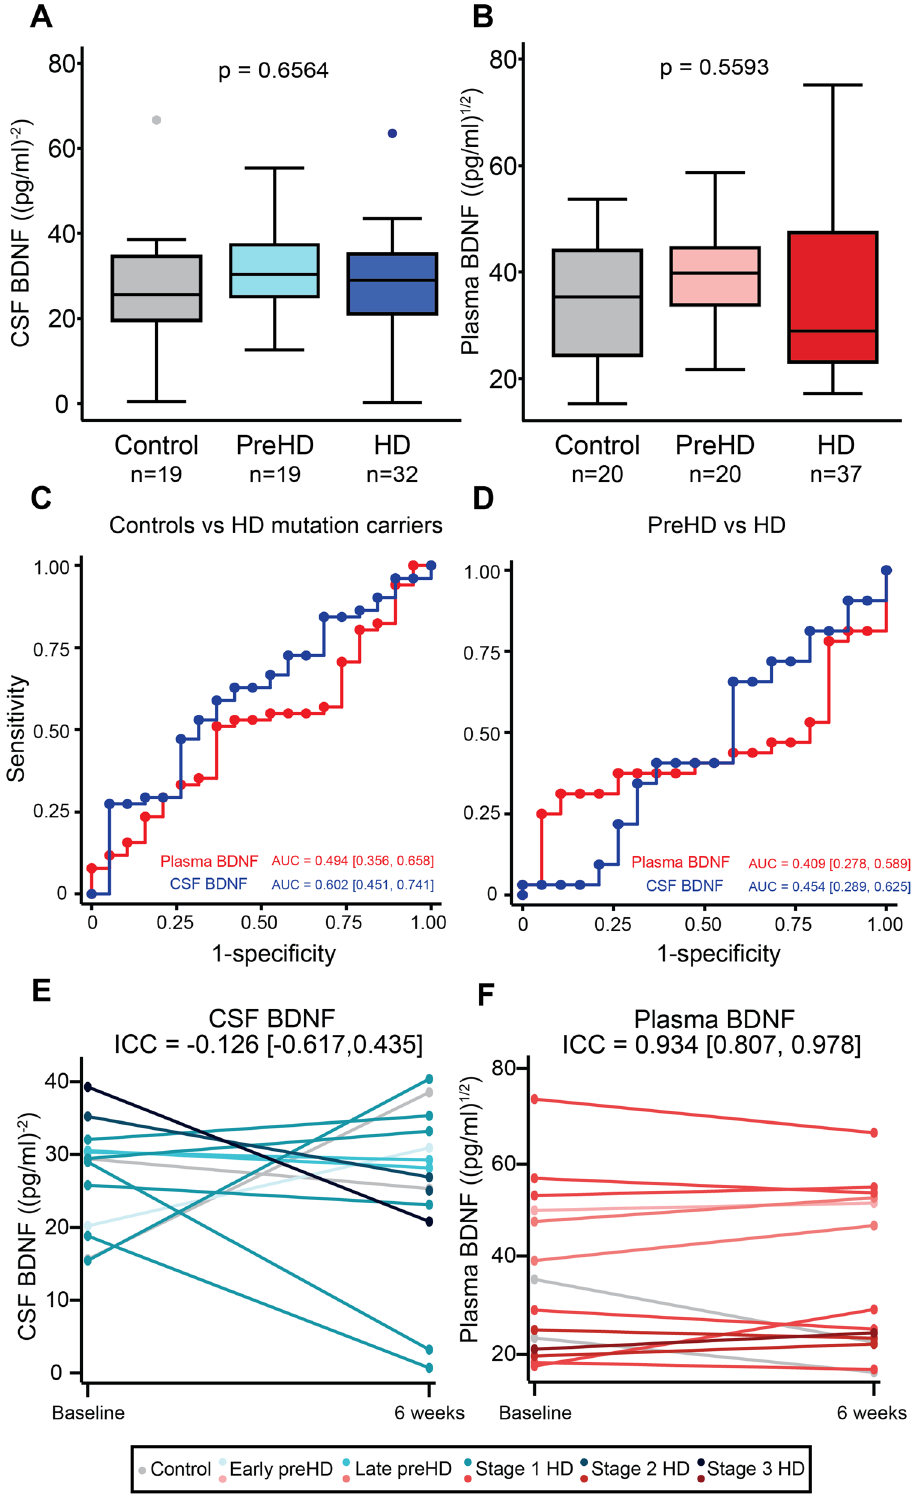
Figure 2. Baseline BDNF plots. Concentration of BDNF in CSF ( A ) and plasma ( B ) in healthy controls, premanifest HD (PreHD), and manifest HD (HD) patients. Comparison were generated with general linear models and were adjusted for CSF (gender, BMI, anti- depressant, anti-psychotic medication, age, CAG repeats, and erythrocyte count) or plasma covariates (gender, BMI, anti-depressant, anti-psychotic medication, age, CAG repeats, sample storage duration, and platelet count). ROC curves for ( C ) discrimination between healthy control (n = 19) and HD mutation carriers (n = 51) and ( D ) discrimination between premanifest HD (n = 19) and HD patients (n = 32). Results ( A – D ) were replicated at follow-up. Stability of BDNF in CSF ( E ) and plasma ( F ) over approximately 6 weeks was assessed with two-way mixed effects models intraclass correlation (ICC). Each line described the same participant (n = 13 in CSF and n = 14 in plasma) between the baseline and optional 6-week repeated sampling. CSF BDNF values were inverse square transformed and plasma BDNF were square root transformed. AUC, area under the curve; CSF, cerebrospinal fluid; preHD, premanifest HD mutation carriers; HD, manifest HD mutation carriers; BDNF, brain-derived neurotrophic